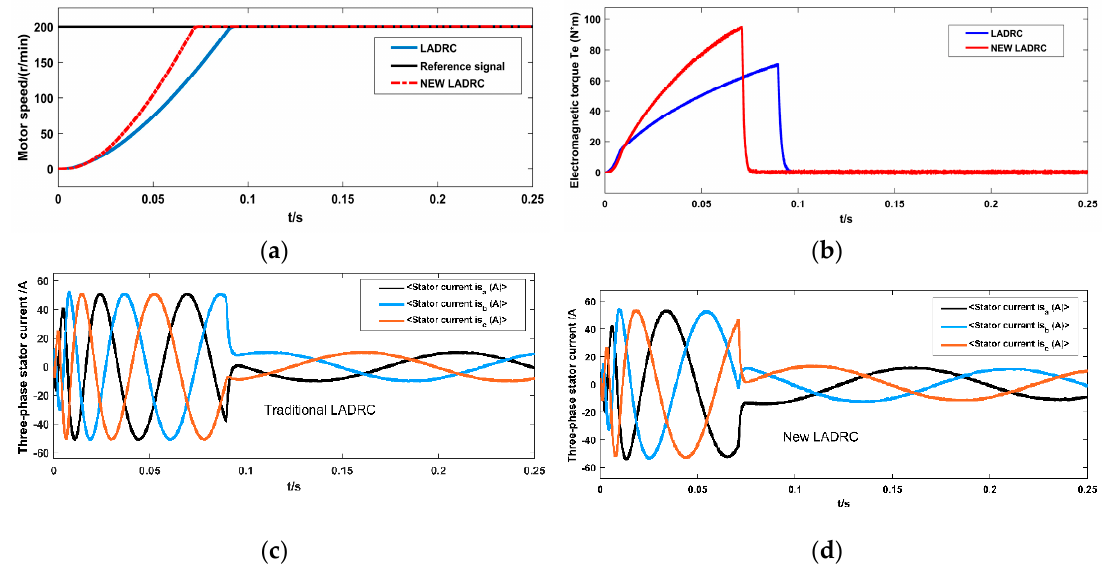
Figure 14. Low-speed simulation of an asynchronous motor. LADRC: Linear ADRC.